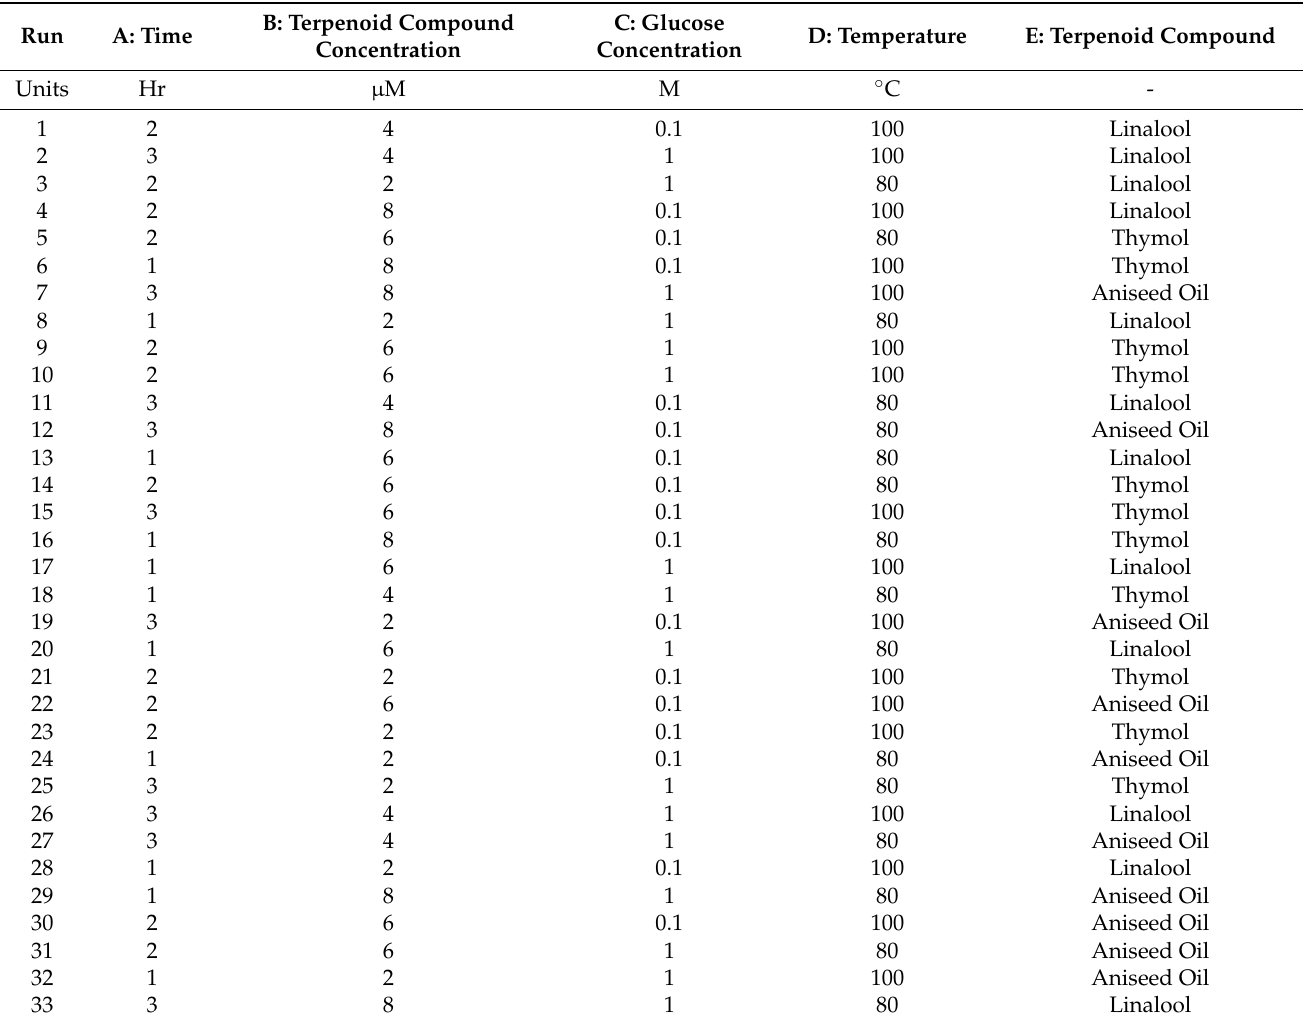
Table 1. Independent experimental factors and design layout